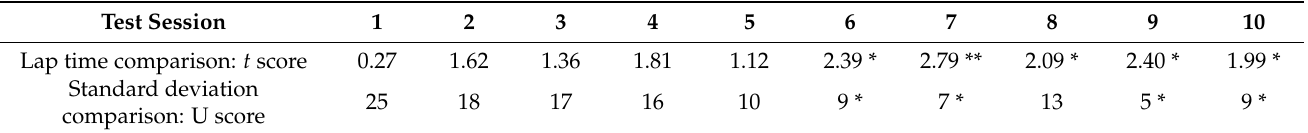
Table 3. Session-level comparison between the experimental and control groups. t score and U score results for comparison of mean and standard deviation lap times,